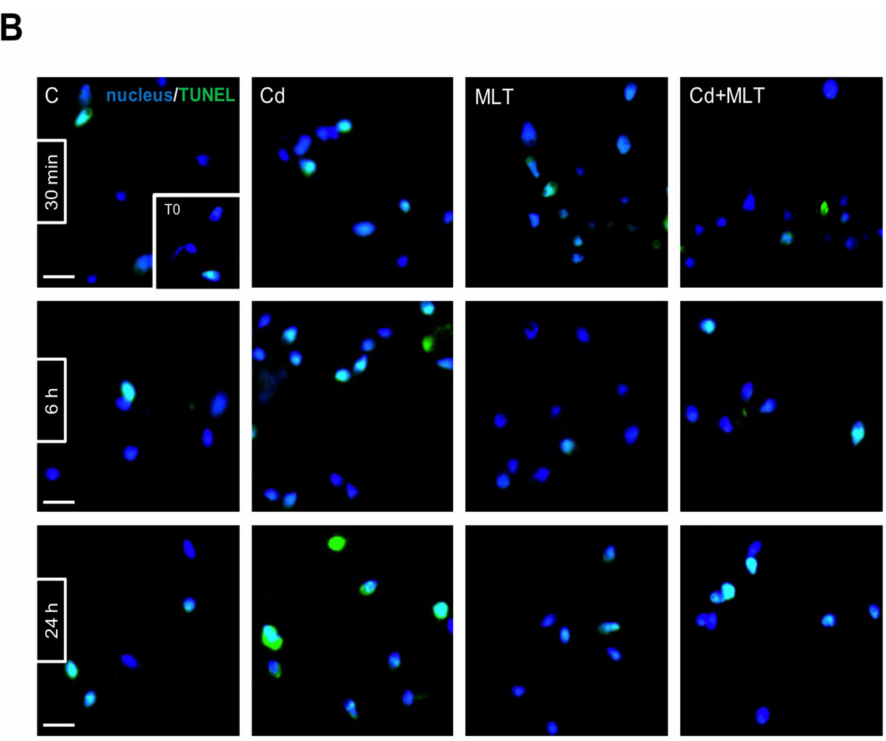
Figure 3. Determination of apoptosis through the TUNEL assay of sperm samples incubated with Cd and/or MLT for 30 min, 6 h, and 24 h. ( A ) Percentage of positive TUNEL cells. Values are expressed as means ± SEM from 15 samples divided into the 5 groups, including the initial control (T0). a vs. b p < 0.05; a vs. c p < 0.01; a vs. d p < 0.001; b vs. c p < 0.05; b vs. d p < 0.01; c vs. d p < 0.01. ( B ) TUNEL assay, that highlight the apoptotic SPZ (green) respect to non-apoptotic (blue) in each analyzed time-points. Slides were counterstained with DAPI-fluorescent nuclear staining (blue). Scale bars represent 10 µ m.